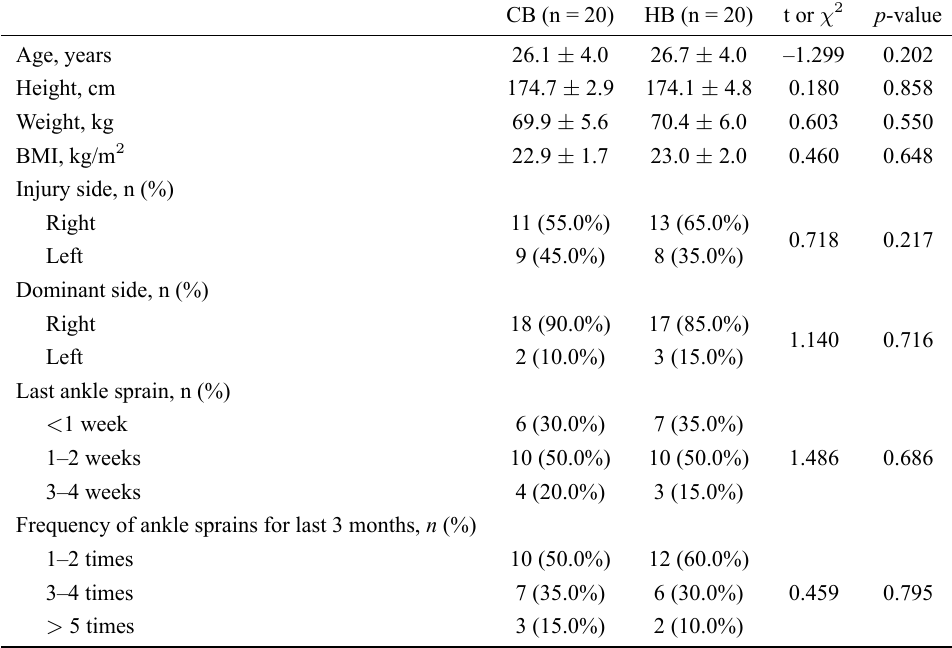
Table 1. Participant characteristics in the CB and HB training groups.